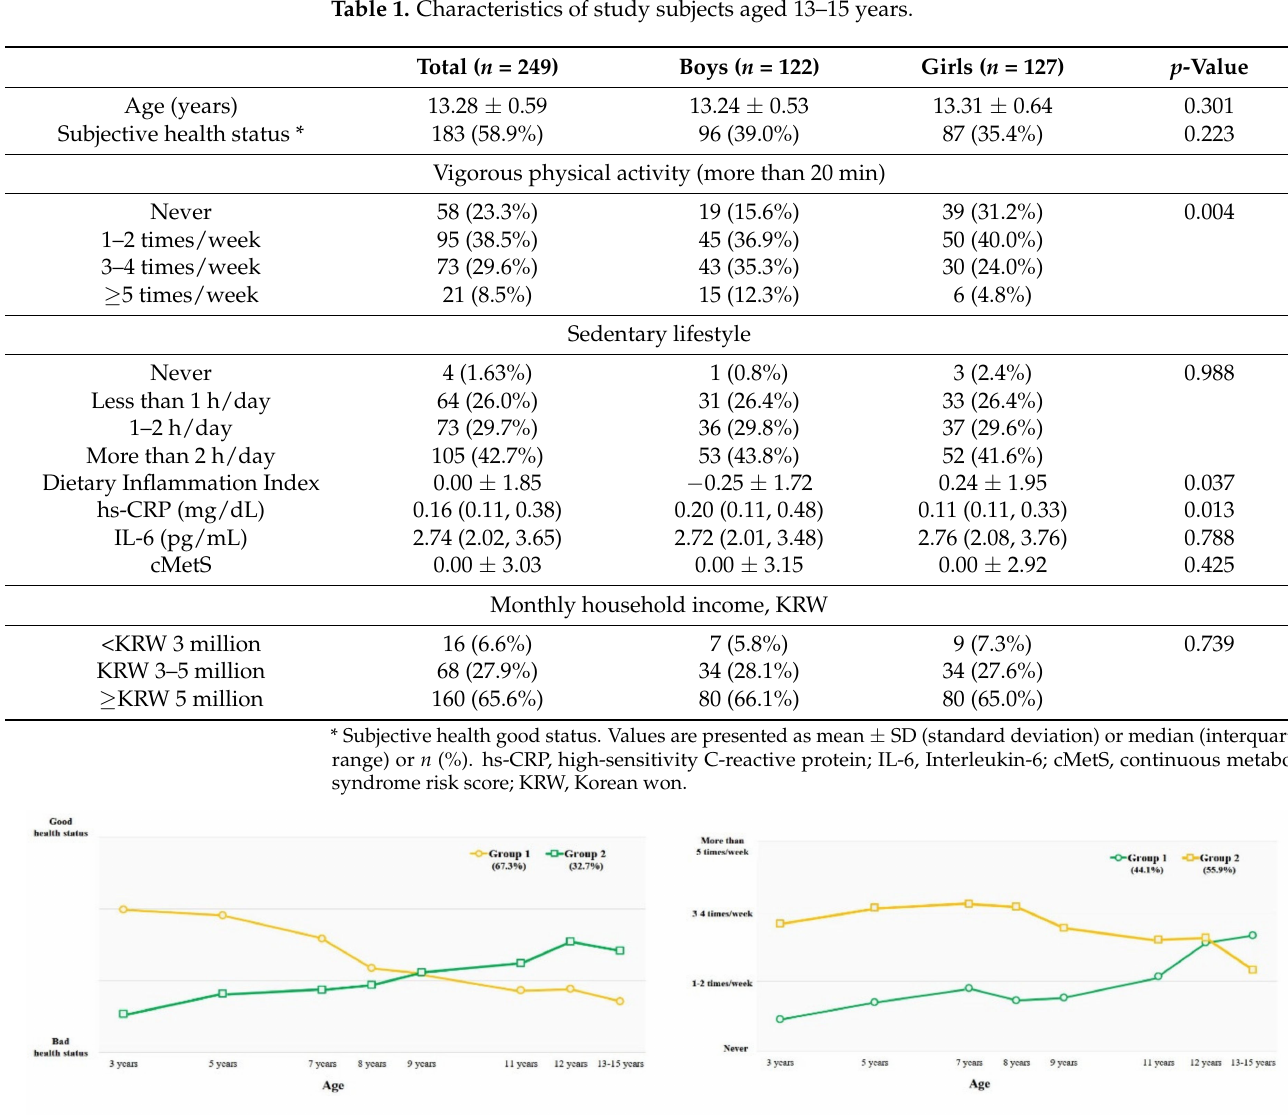
Table 1. Characteristics of study subjects aged 13–15 years.